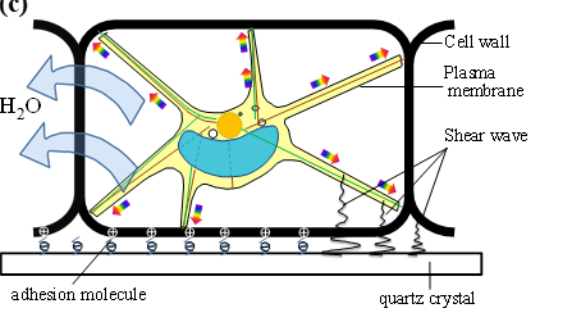
Figure 7. Schematic of the BY-2 cell morphologies under different osmotic stresses. ( a ) C M = C ip , BY-2 cell in normal state and the turgor is zero, the cell membrane exerts no force on the cell wall. ( b ) C M < C ip , BY-2 cell absorbs water and the cell membrane would pressurize the cell wall, and in turn the cell wall pressurizes the QCM chip, there is a certain degree of shape change in the cell wall. ( c ) C M > C ip , BY-2 cell loses water. As the loss of water, the vacuoles and the cell membrane shrink and plasmolysis would